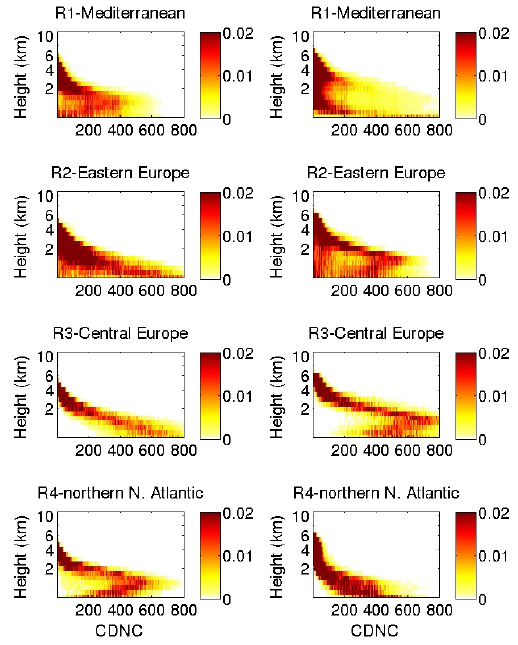
Figure 6. Seasonality in the vertical distributions of CDNC (cm − 3 ) shown as joint histograms averaged over winter averaged (DJF) months (first column) and summer averaged (JJA) months (second column) for the selected four regions. The colour scale indicates the normalized frequency.